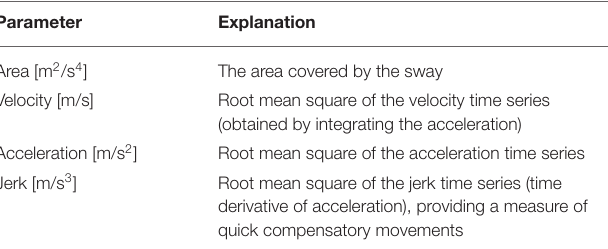
TABLE 1 | Description of the parameters used in this